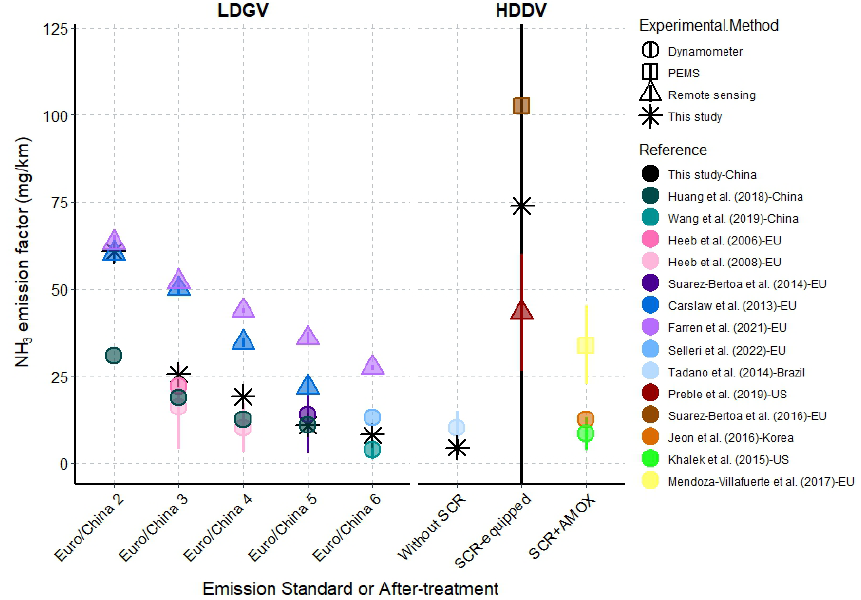
Figure 1. Comparison of distance-based NH 3 EFs for of LDGVs and HDDVs in this study and other relative studies, disaggregated by emission standard or after-treatment technology.